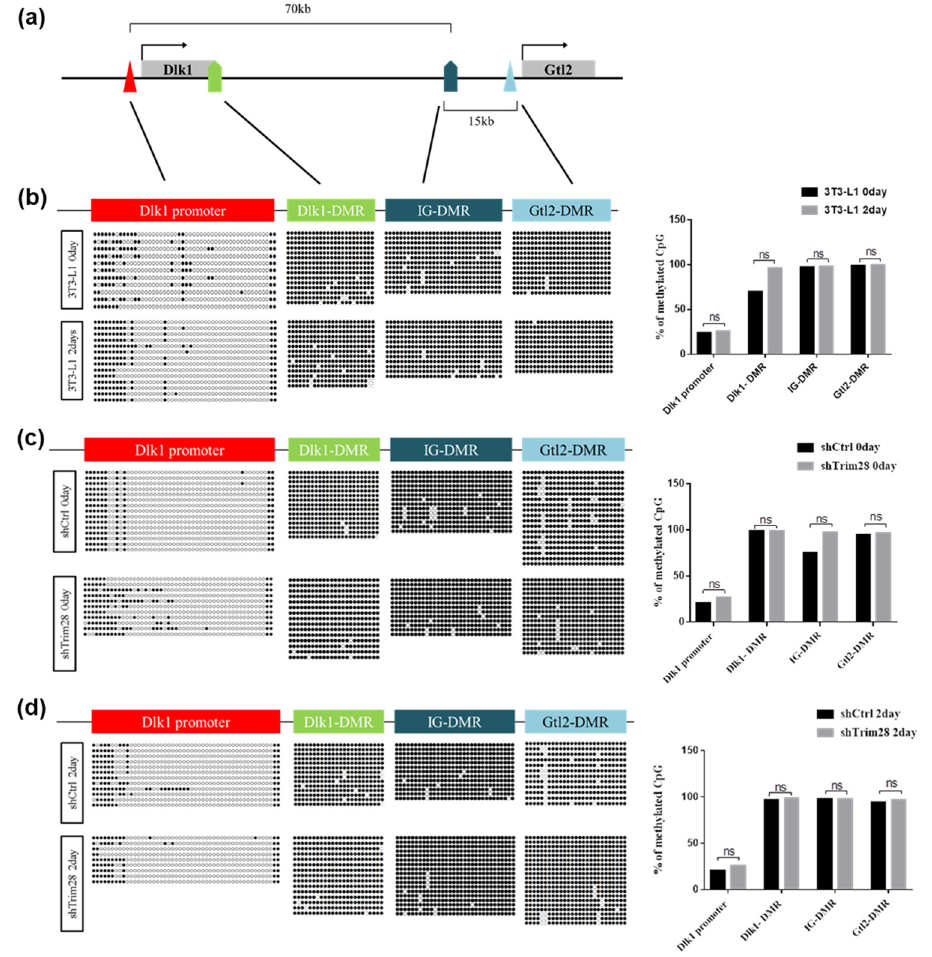
Figure 5. DNA methylation analysis on Dlk1 promoter and differentially methylated regions (DMRs) of Dlk1-Gtl2 gene cluster. ( a ) The schematic diagram of the Dlk1-Gtl2 gene cluster. The Dlk1 promoter, Dlk1 -DMR, IG-DMR, and Gtl2 -DMR were analyzed for DNA methylation. ( b ) Bisulfite sequencing of the day 0 and day 2 differentiated 3T3-L1 cells depicting the methylation status of each individual CpG island in these DMRs. The circle indicates a single CpG dyad; open circles represent unmethylated CpGs and filled represent methylated CpGs. Quantitative analysis of methylation status in total CpG dyads at Dlk1-Gtl2 DMRs via sanger sequencing. The data were estimated by two-way ANOVA, ns indicates not significant. ( c ) Bisulfite sequencing of day 0 undifferentiated Trim28 KD cells and shCtrl 3T3-L1 cells. ( d ) Bisulfite sequencing of day 2 differentiated Trim28 KD cells and shCtrl 3T3-L1 cells.